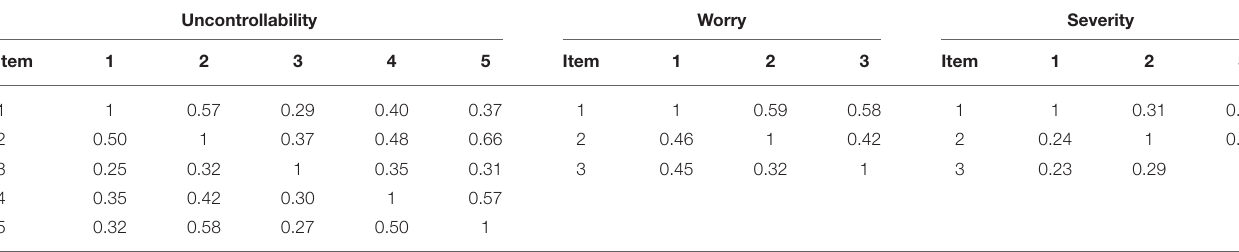
TABLE 1 | Observed correlations and corrected correlations among items in three factors. Uncontrollability Worry Severity